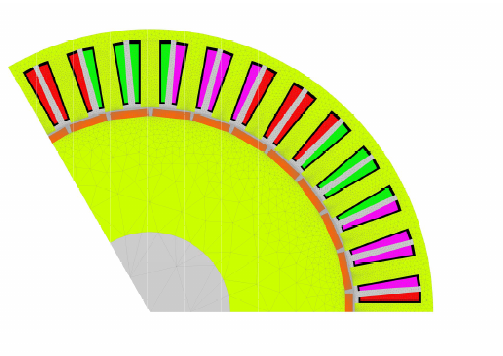
Figure 9. Geometry of the sized machines (Qs36p15).